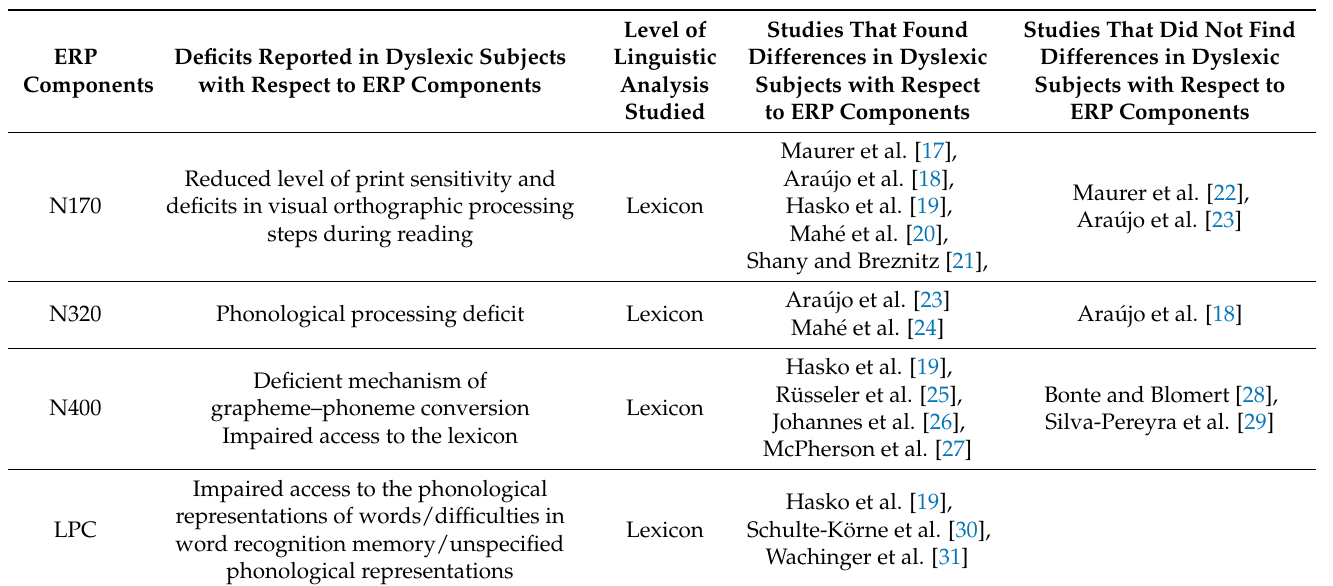
Table 1. Summary of the deficits in ERP components reported in dyslexic versus non- dyslexic